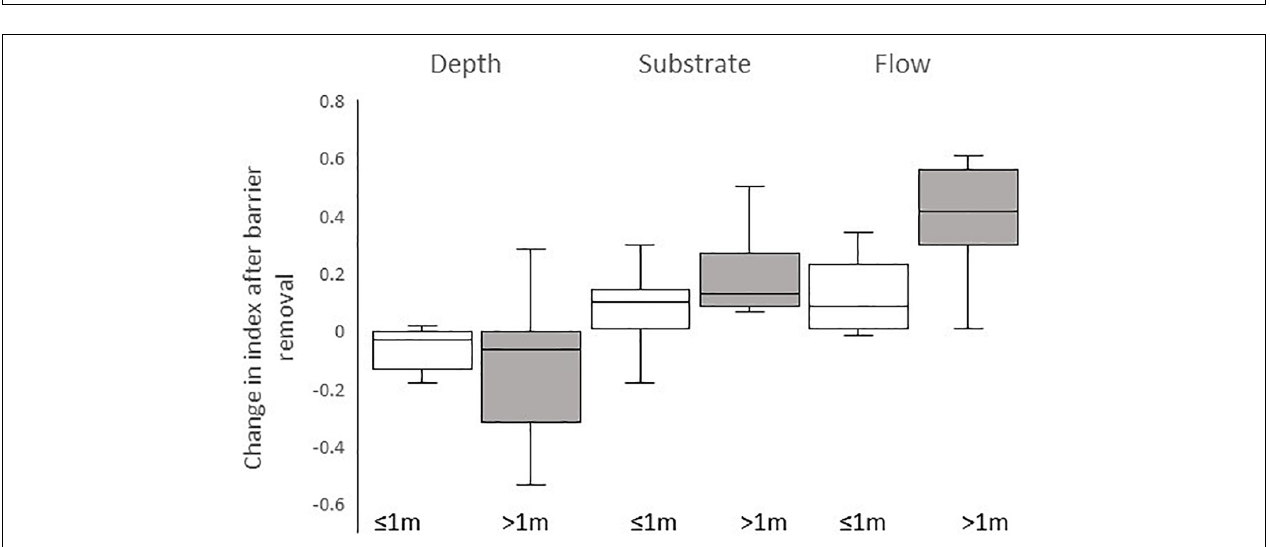
FIGURE 2 | Index of (A) depth, (B) substrate, and (C) flow before and after barrier removal. Red triangle symbols depict DK sites; blue circles depict UK sites.